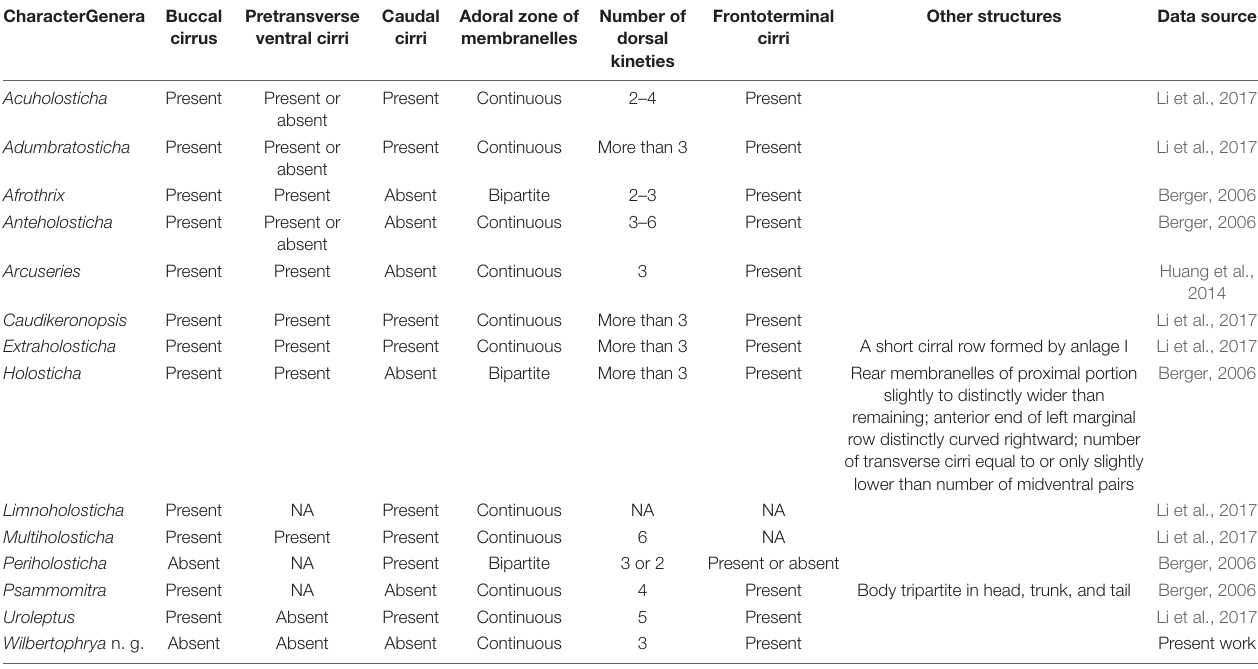
TABLE 2 | Morphological comparison of Wilbertophrya n. g. with similar